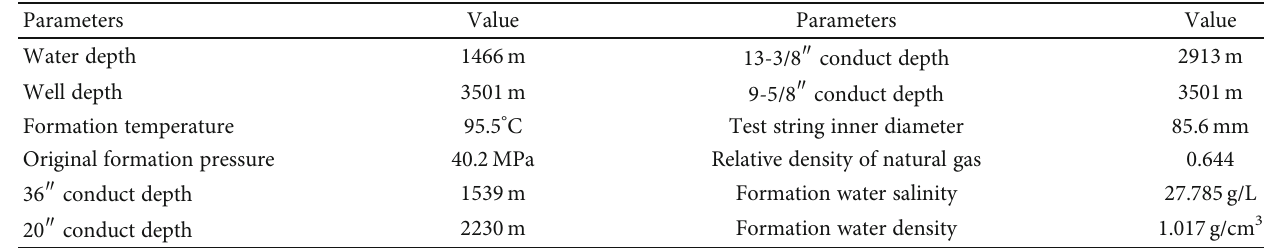
Figure 3: The prediction method of hydrate formation region. Table 3: Basic data of the case well.